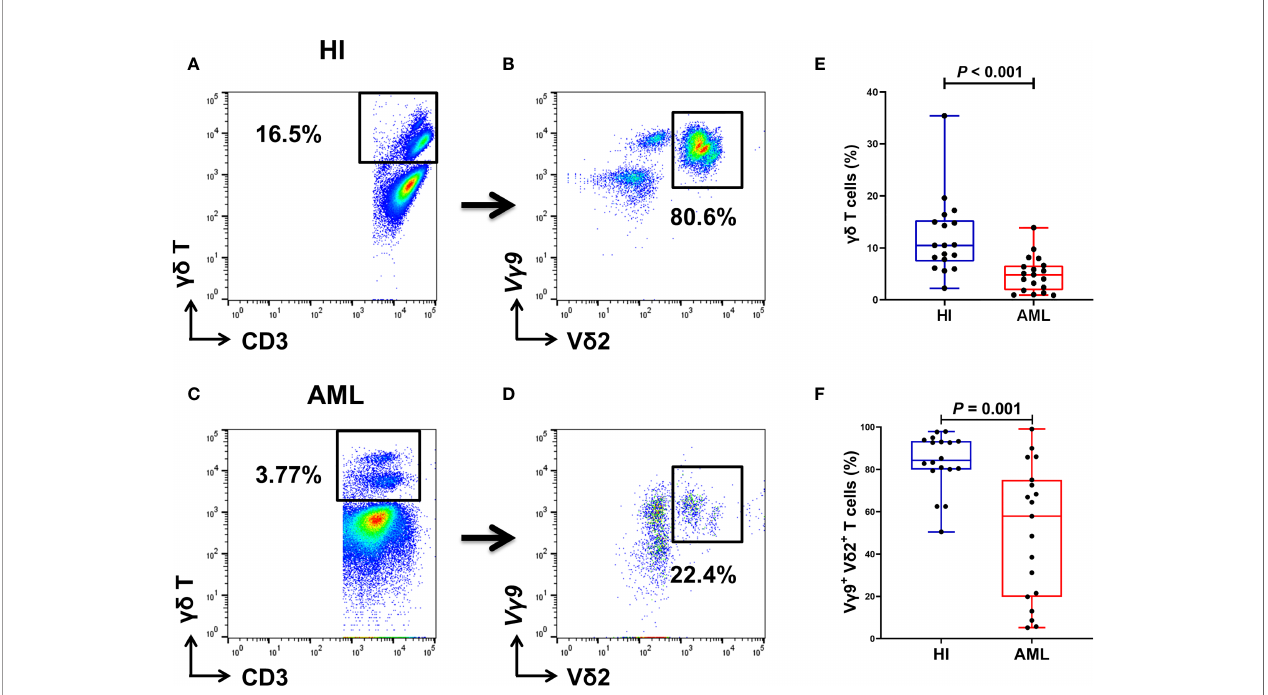
FIGURE 4 | Gating strategy for identifying the percentage of gd T cells from PB in 18 HIs and 19 patients with AML. Flow cytometry detection of the percentage of CD3 + gd T cells and V g 9 + V d 2 + T cells in HIs (A, B) and patients with AML (C, D) . The percentage of gd T cells in HIs and patients with AML (using the Mann Whitney test) (E) . Comparison of the percentages of V g 9 + V d 2 + T cells in HIs and patients with AML (using the Mann Whitney test) (F) .